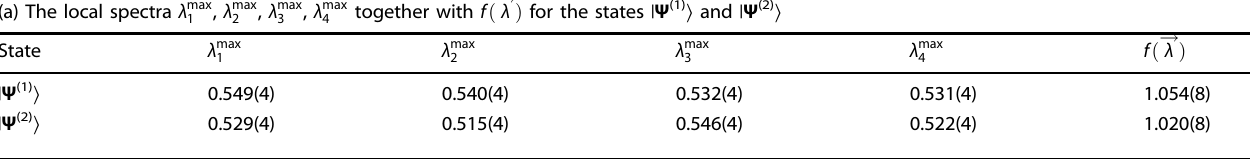
, λ max , λ max , λ max 1 2 3